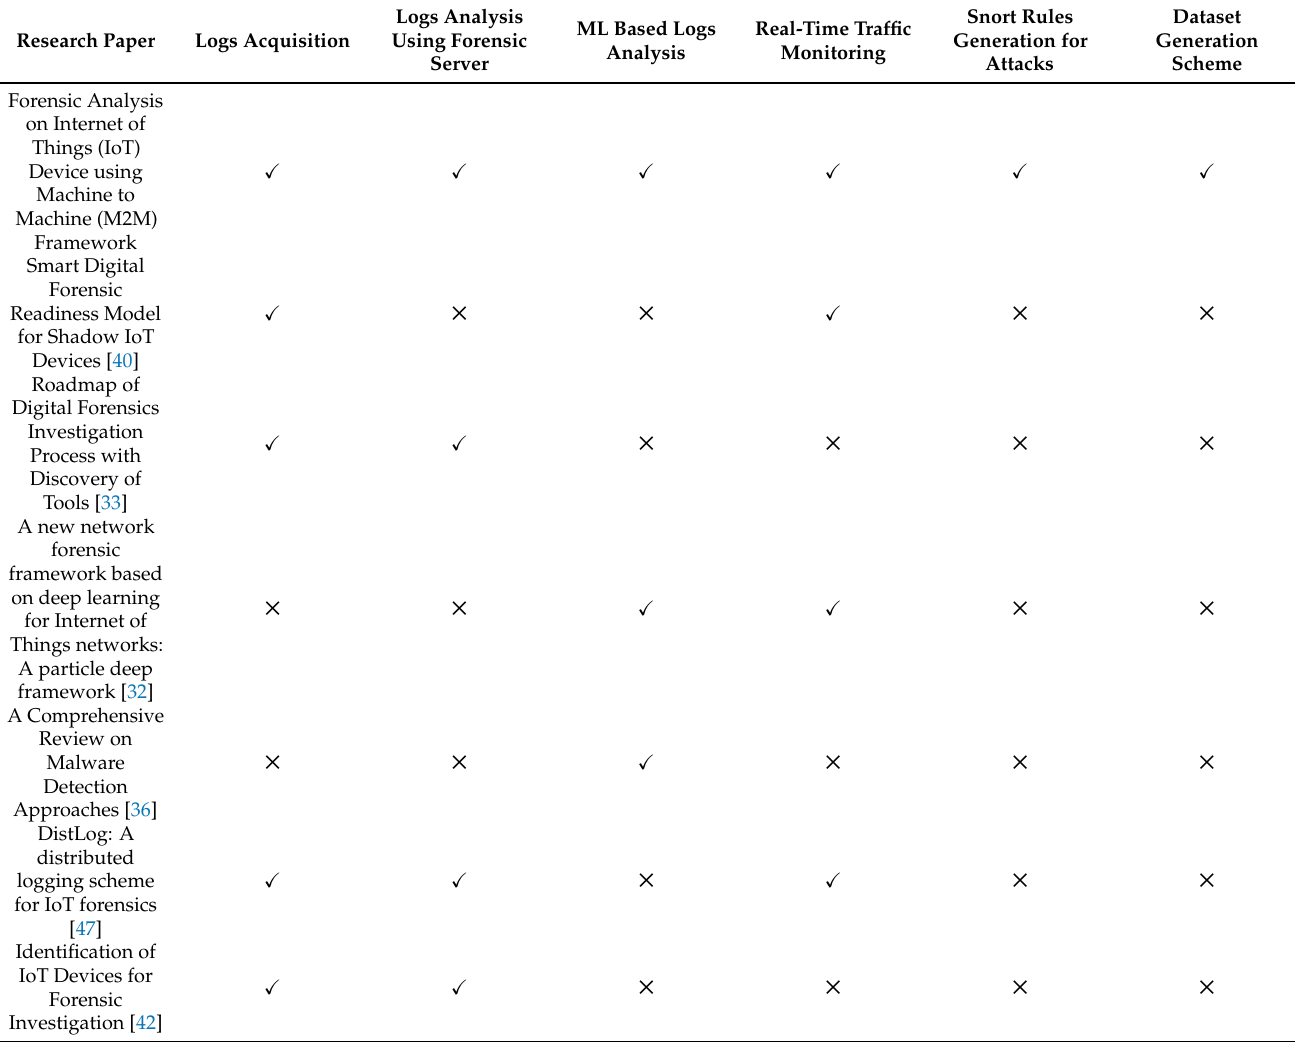
Table 6. Comparative analysis with various